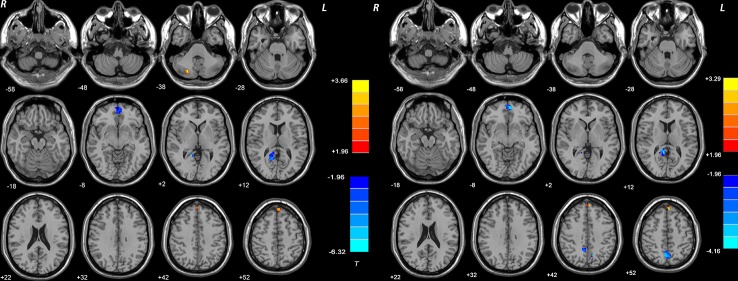
Brain regions with significant difference in DMN NH between patients and healthy controls at baseline. The color bar represents the t values of the group analysis of NH. Left: DPP group vs healthy controls. Brain regions with significant difference were observed in the right Cerebellum Crus II, bilateral ventral MPFC, right Precuneus/PCC, and bilateral superior MPFC. Right: DT group vs healthy controls. Brain regions with significant difference were observed in the bilateral ventral MPFC, right Precuneus/PCC, bilateral Precuneus, and bilateral superior MPFC. DPP, drug plus psychotherapy; DT, drug therapy; DMN, default-mode network; NH, network homogeneity; MPFC, medial prefrontal cortex; PCC, posterior cingulate cortex.